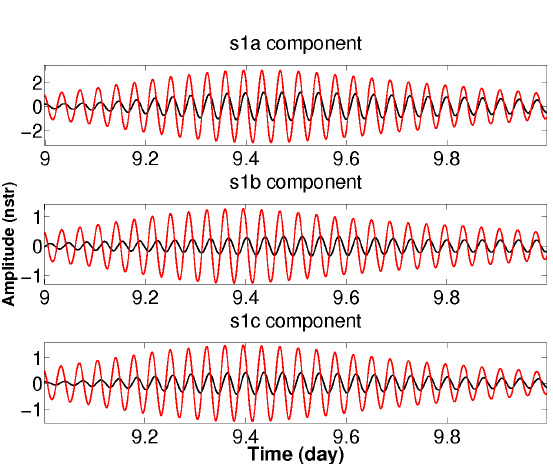
Figure 11. One day of residual strain signals during june 2010, in the 50-55mn period range: (black curves) residual sig- nal, (red curves) observed signal due to the seiche. The residual amplitude is of the order of ∼ 10 − 9 . The stabil- ity of the phase delays between the original records and the residuals can be explained by the a constant phase shift, due to the 14 km distance between the tide-gage in Trizonia and the coast line near MOK.